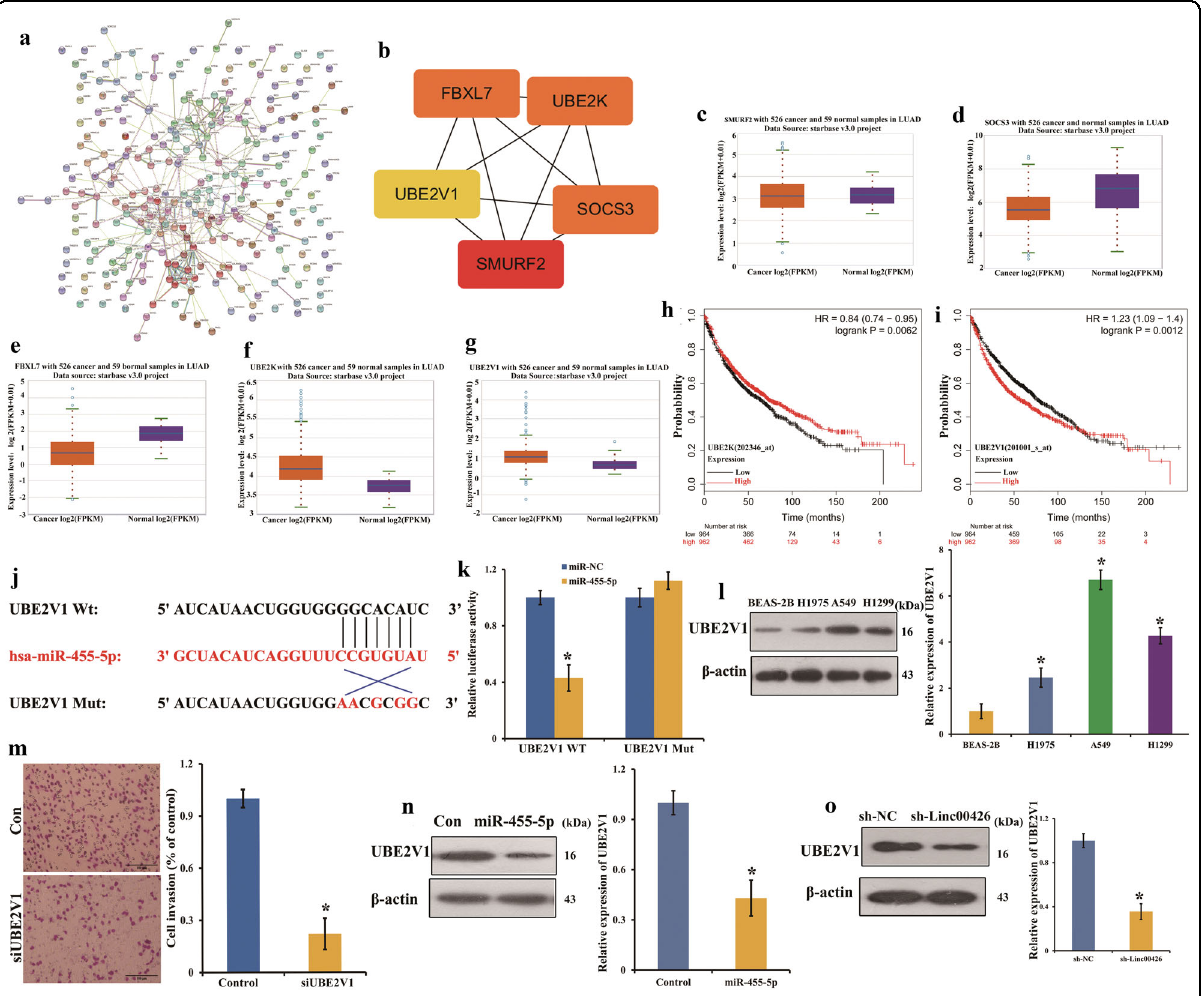
Fig. 5 Linc00426 serves as a ceRNA by sponging miR-455-5p and modulating UBE2V1. a PPI network of targeted genes. b Hub genes of targeted genes. c – g Expression of hub genes in LUAD and normal lung tissues. h , i Kaplan – Meier plots of UBE2K and UBE2V1. j The UBE2V1 3 ′ -UTR WT and UBE2V1 3 ′ -UTR Mut. k The luciferase activity of transfected cells. Student ’ s t test. i The expression of UBE2V1 in LUAD cells and BEAS-2B cells is determined by Western blot. One-way ANOVA. m Effects of UBE2V1 on the invasive ability of A549 cells with control and siUBE2V1. Scale bar